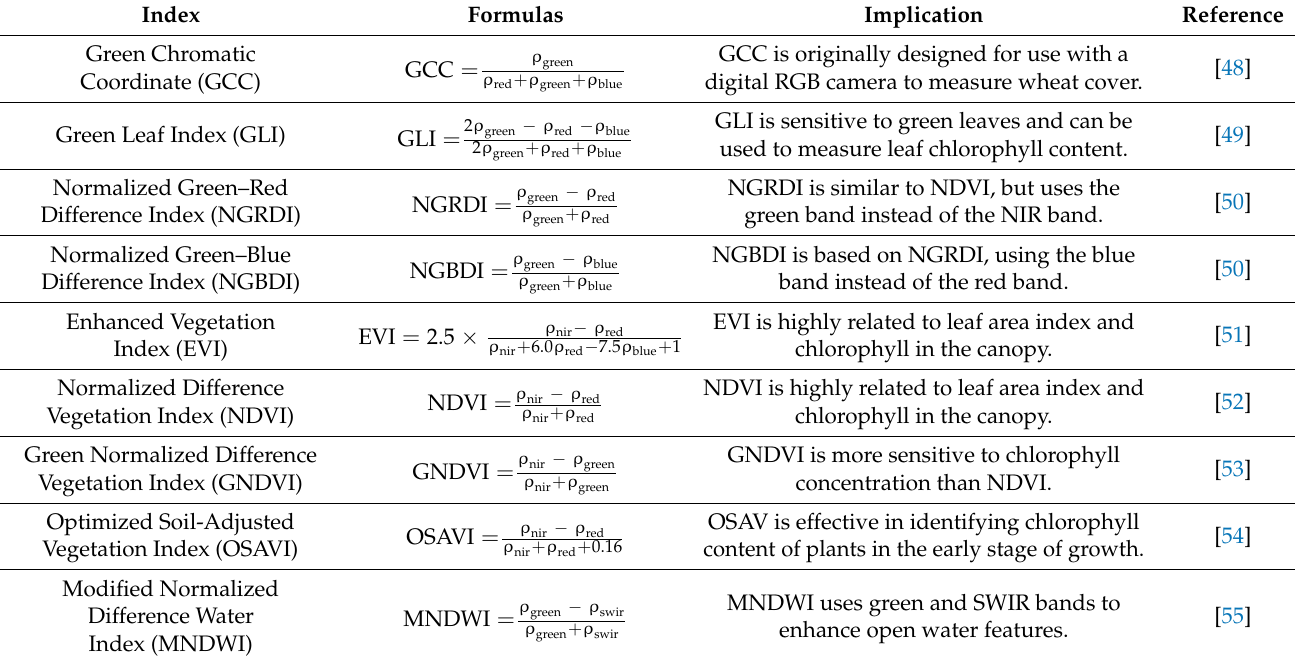
Table 1. The indices used in this study.